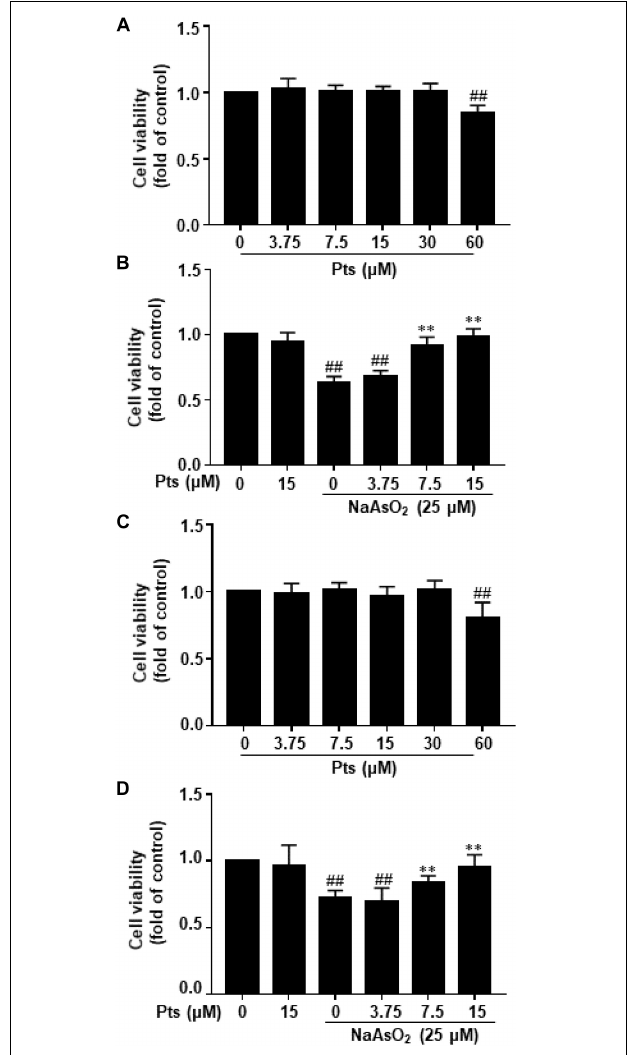
FIGURE 1 | Protective effect of Pts pretreatment against NaAsO 2 -induced cytotoxicity in HaCaT and JB6 cells. (A,C) The HaCaT and JB6 cells were exposed to different concentrations of Pts (7.5–60 µ M) for 24 h, and then cell viability was measured by MTT assay. (B,D) HaCaT and JB6 cells were exposed to NaAsO 2 (25 µ M) for 24 h with or without pretreatment with Pts (3.75, 7.5, and 15 µ M), and then cell viability was measured by MTT assay. The results are expressed as the means ± S.E.M. of three independent experiments. ## P ≤ 0.01 versus the control group, ∗∗ P ≤ 0.01 versus the NaAsO 2